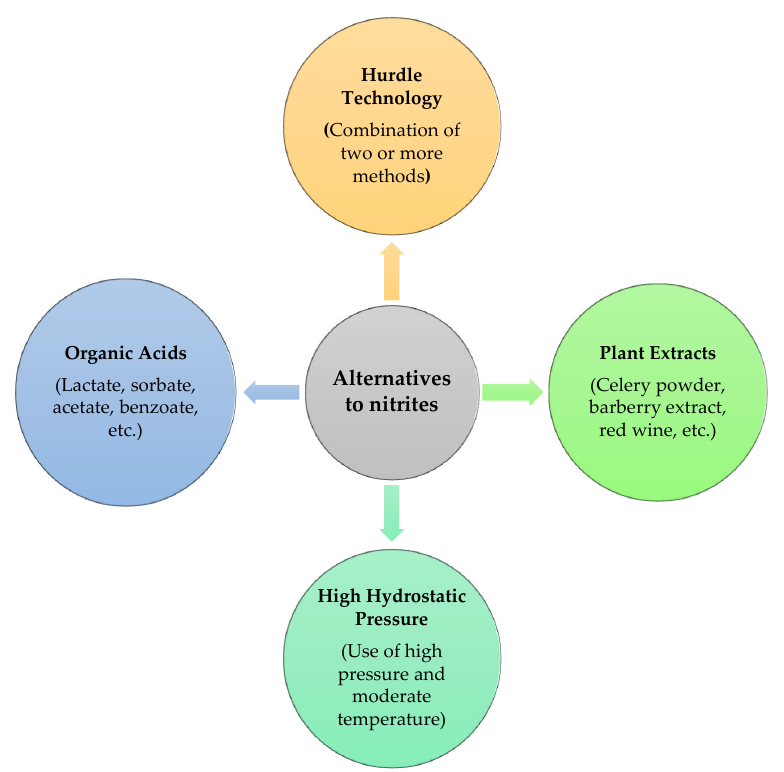
Figure 4. Alternatives to nitrite in processed meat.